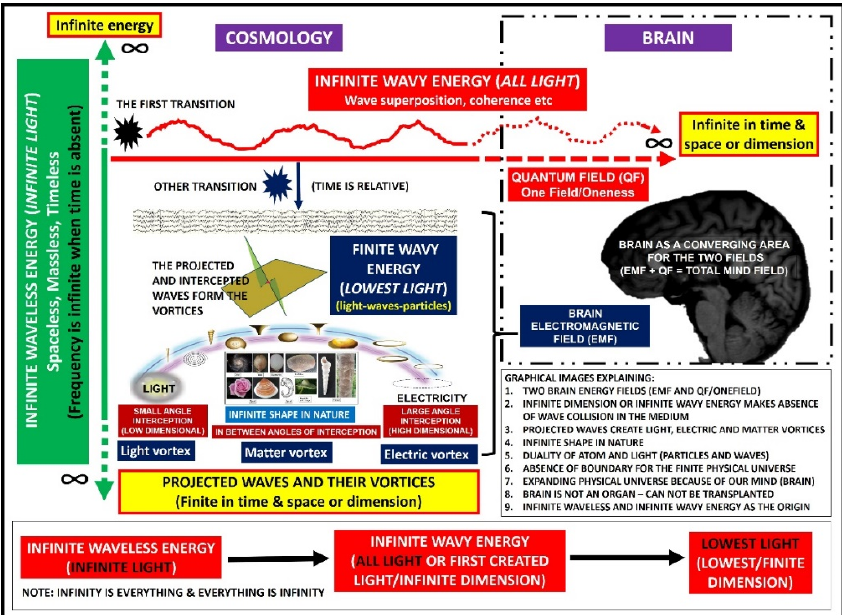
Figure 6. A graphical summary of our new perspective on brain function, which covers infinite waveless (infinite light), infinite wavy (all light), and finite wavy energy (comprises the lowest light), projected wave-vortices, quantum field, and electromagnetic field.